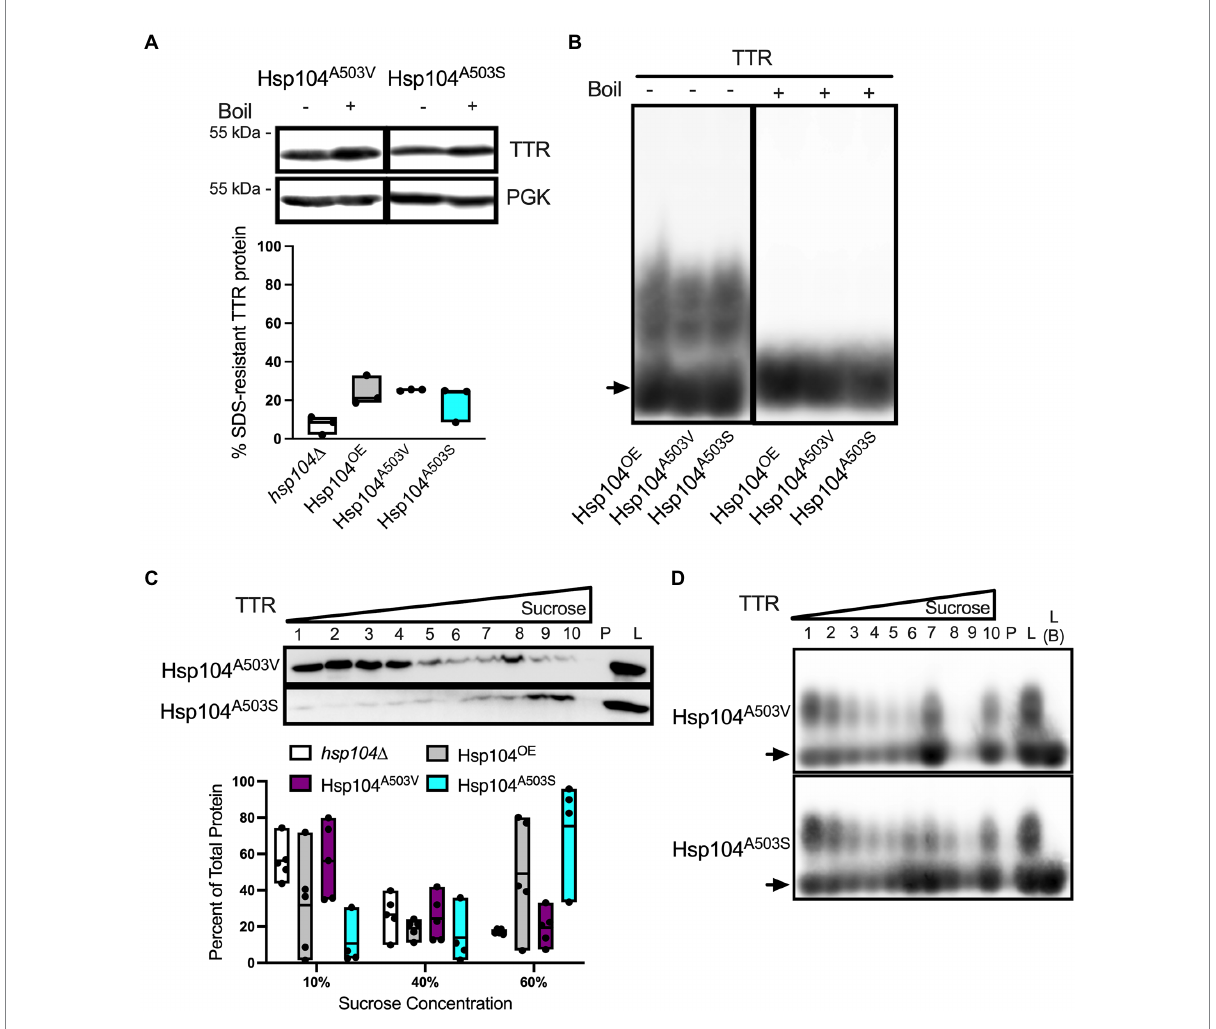
FIGURE 4 Strains expressing Hsp104 A503V show different sedimentation profiles compared to strains expressing Hsp104 OE . (A) Similar to Figure 2A, TTR expressing hsp104 ∆ strains co-transformed with either Hsp104 OE , Hsp104 A503V , or Hsp104 A503S . (Top) Representative Western blots. (Bottom) Quantification is from 3 independent trials. hsp104 ∆ and Hsp104 OE data from Figure 2A. Data is shown as means and ranges. (B) Log culture lysates of indicated strains were resolved by SDD-AGE. The arrow denotes TTR monomers. Representative images are shown. (C) Western blot of lysates from the indicated log strains subjected to a discontinuous sucrose gradient. (Top) Representative blots of TTR sedimentation from lysates, and (Bottom) quantification of TTR signal as percent of total protein, as in Figure 3A. hsp104 ∆ and Hsp104 OE data from Figure 3A. All quantification represents 4–5 independent cultures per strain. Data is shown as means and ranges. (D) Sucrose gradient fractions of indicated strains were resolved by SDD-AGE as in Figure 3B. Arrows denote TTR monomers. Representative images are